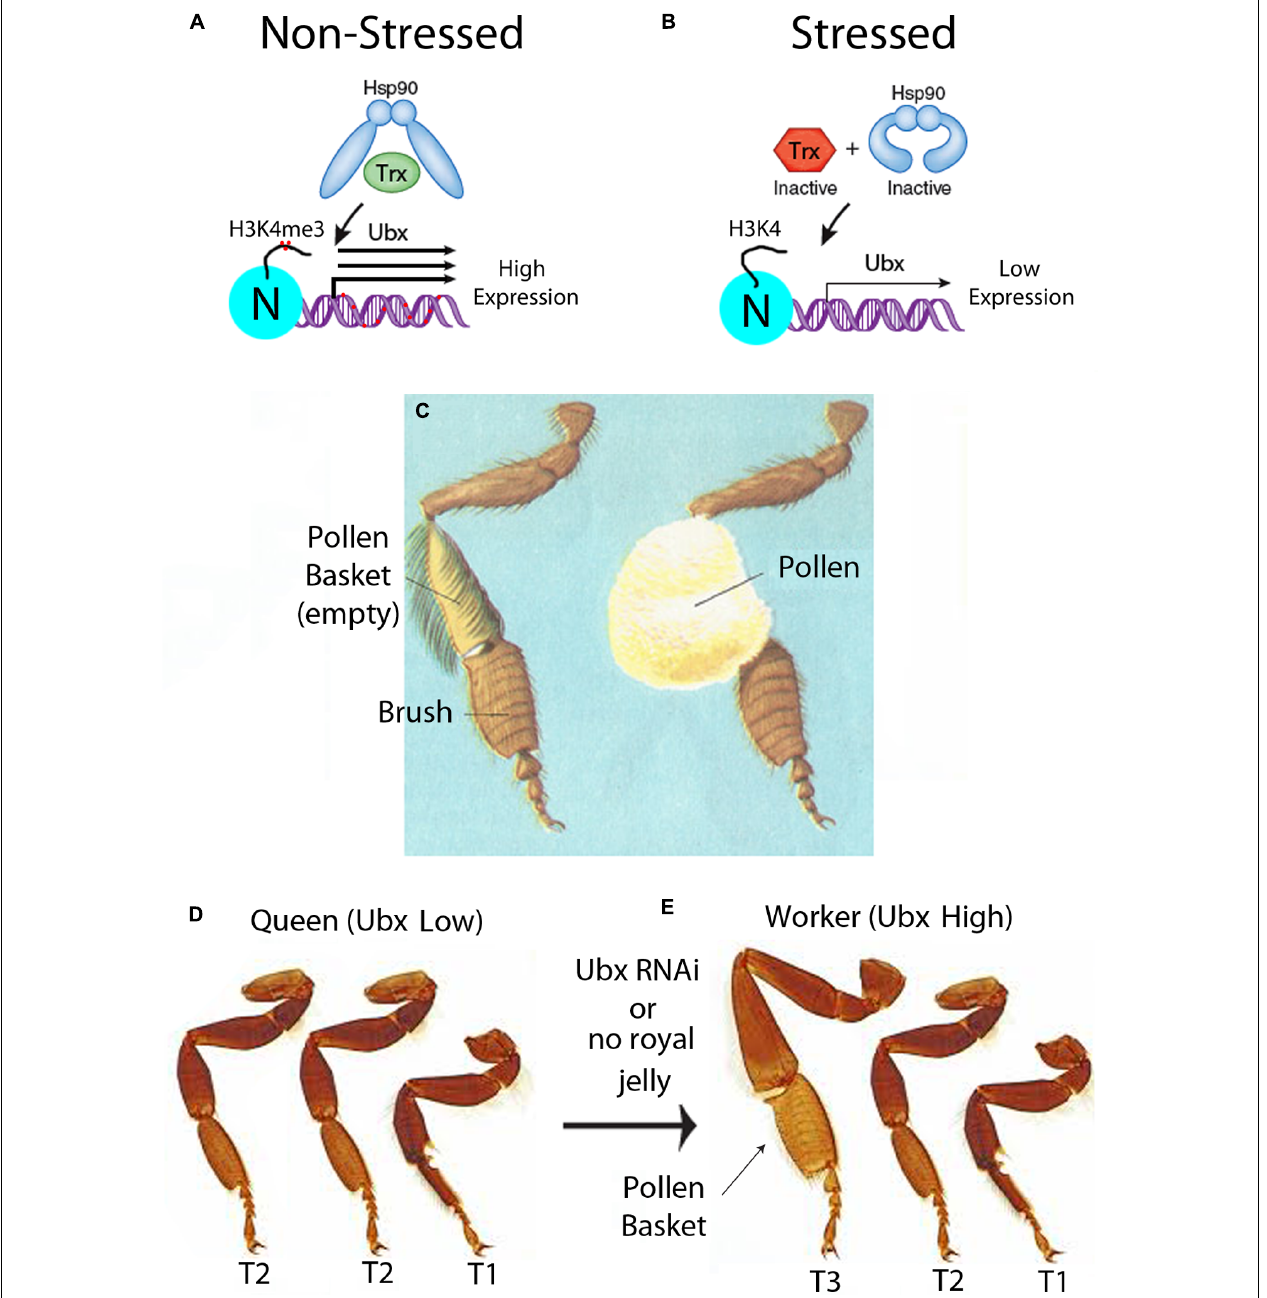
laboratory and we retain the copyright (Ruden, 2011). (B) In stressed conditions, Hsp90 is inactive and cannot activateTrx, and transcription of Ubx is low. (C) Diagram of an empty and full pollen basket in forager bees.This diagram is used with permission from the Encyclopedia of Science, Copyright © TheWorlds of David Darling (http://www.daviddarling.info/). (D) In queens, the pollen basket does not form because Ubx is low inT3.This causes an anterior transformation of the third thorax (T3) leg to look like the T2 leg. (E) In workers, the pollen basket forms because Ubx expression is high inT3.This figure represents a simplified representation of the homotic transformation that occurs when Ubx levels are reduced and are not meant to be accurate illustrations.This photograph is used with permission from Spike Walker,Wellcome Images, London